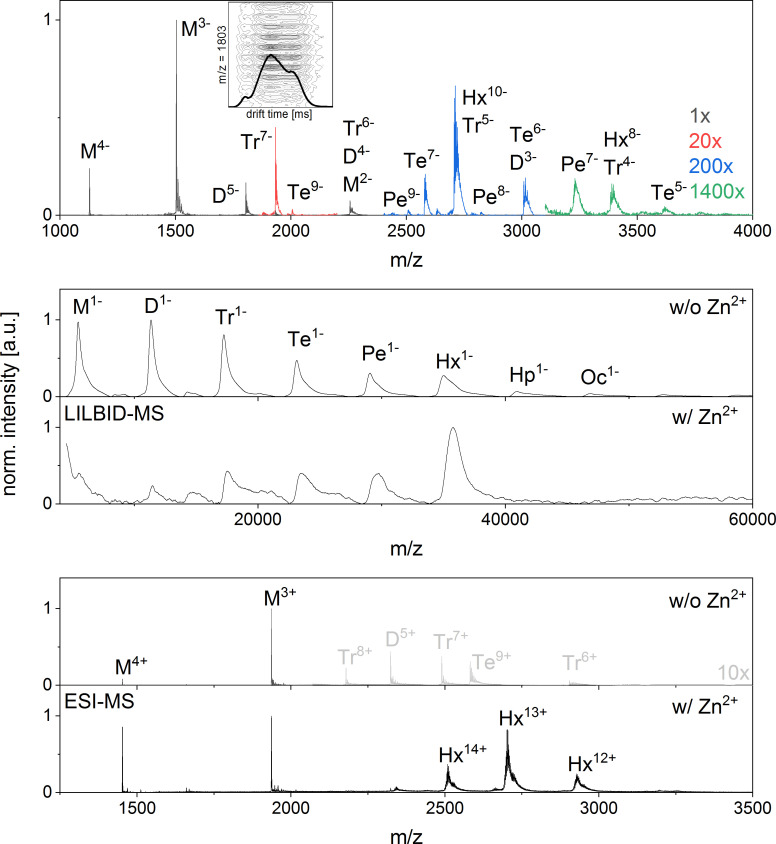
nESI mass spectrum of Aβ42in negative ion mode and LILBID and nESI spectrum of insulin showing a clear formation of a hexamer upon zink addition.(A) nESI Spectra of Aβ42 in negative mode show similar characteristics to those taken in positive mode (compare Appendix 1—figure 1). Several oligomerization states can be seen, albeit at lower and lower intensity for the higher the oligomeric states (upscaling of the signal intensity was done as indicated in the figure). As the oligomerization of Aβ42 was previously described as a process progressing via hexamers (Bernstein et al., 2005), we briefly explain here, why we support the notion of linear growth. Both MS methods applied here show Aβ42 in different oligomeric states with decreasing intensity for higher oligomeric state and no mass peaks indicating a dominant hexamer. Mass spectra published by Bowers et al. don’t show any dominant hexamers either, but the presence of tetramers and more dominant hexamers is deduced from different features seen in drift scope plots for the same m/z signals (Bernstein et al., 2005). Different drift times for one m/z ratio can be caused by different conformations of one oligomer species or by overlap of different charge states of different oligomers. Therefore for example the three different drift times for a nominal −5/2 charged monomer were interpreted as five times charged dimer, 10 times charged tetramer and 15 times charged hexamer. We reproduced these measurements and could similarly observe different drift times for m/z = 1806 in positive (Figure 2B) and negative ion mode (Inset in A). As our mass spectra show isotopic resolution we can nevertheless show that the alternative interpretation holds true: these drift times belong to different confirmations of only one oligomeric state – the dimer. This is true for all the species discussed in the work of Bowers and coworkers (Bernstein et al., 2005). We therefore see no indication for tetramer or hexamer in the drift time plots of these mass peaks, and only very low intensity higher oligomers in the mass spectra. For comparison we investigated insulin, a protein, which is known to aggregate to a hexamer in the presence of zinc ions (Dodson et al., 1979) B shows LILBID results and C shows nESI results of insulin (10 µM insulin in 50 mM ammonium acetate buffer), both without (i) and with (ii) 1.5-fold excess of zinc respectively. Without zinc some aggregation can be seen with both methods, albeit more of the higher oligomers are retained in the LILBID spectrum, which is similar to our observations for Aβ42 (compare Appendix 1—figure 1 and 9). Upon addition of zinc the oligomer distribution shifts to a dominant hexamer, which is clearly visible in both mass spectra. In contrast the hexamer appears in low intensity only for Aβ42.